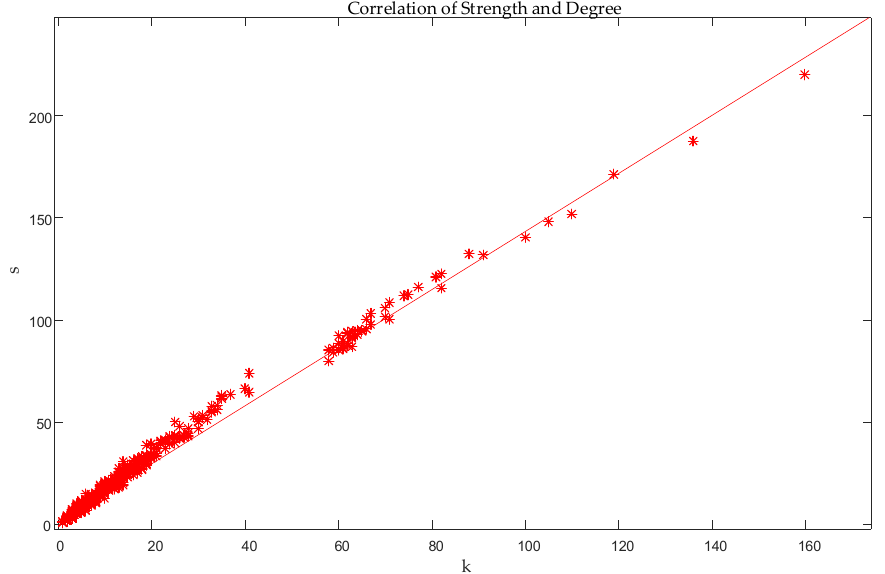
Figure 5. Space information network characteristics analysis at the initial moment: Distribution of the correlation of strength and Degree.